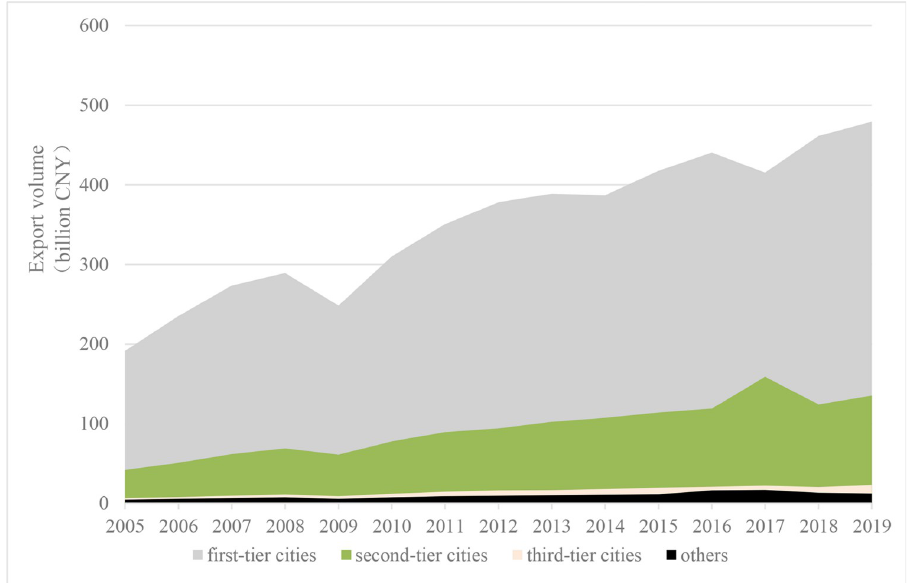
Fig 4. Average city exports at different development of the city